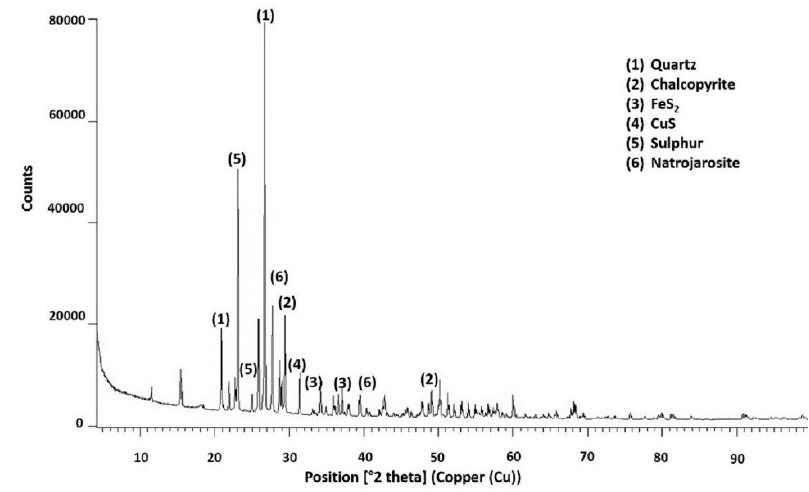
Figure 17. Species identified by X-ray diffraction in residues after chalcopyrite leaching at 90 °C after pretreatment with 15 kg/t of H 2 SO 4 and 25 kg/t of NaCl and 15 days of curing.